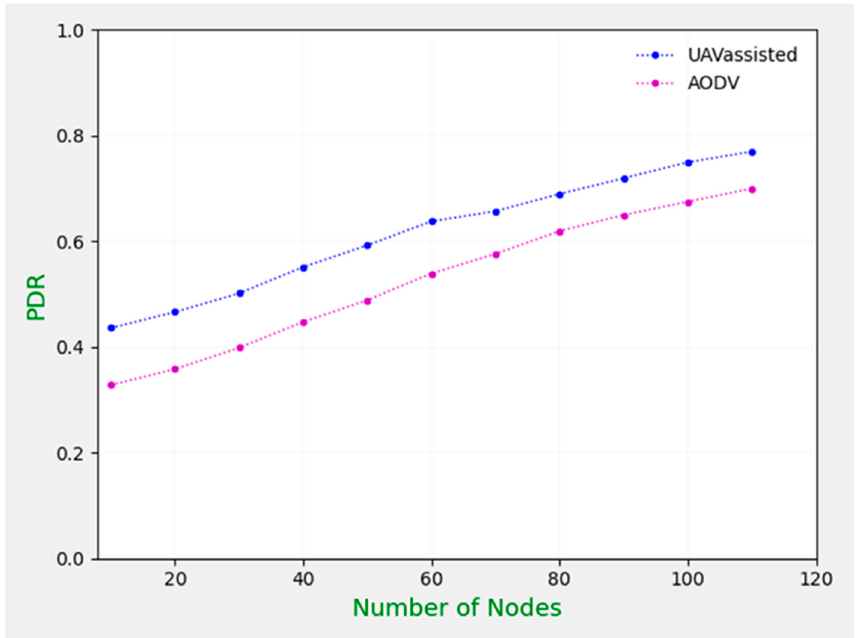
Figure 7. Packet delivery ratio.